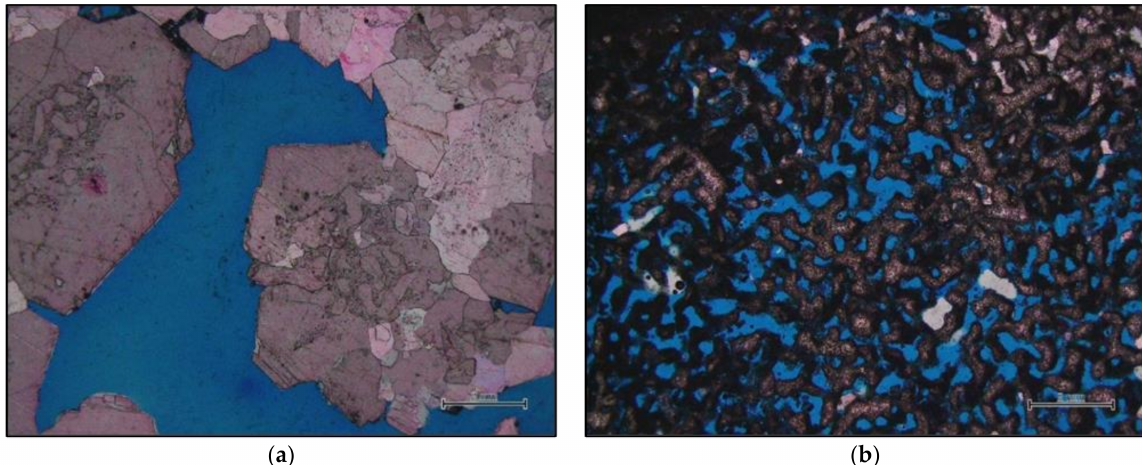
Figure 11. ( a ) Vug size of 4 mm observed on thin section in Jintan-2 well at 1649.6 m depth. ( b ) Moldic porosity of coral growth framework pore type observed on thin section in Jintan-2 well at 1680.8 m depth.